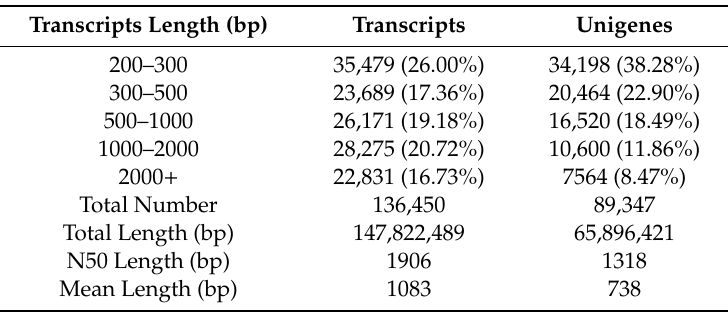
Table 2. Statistics of assembly